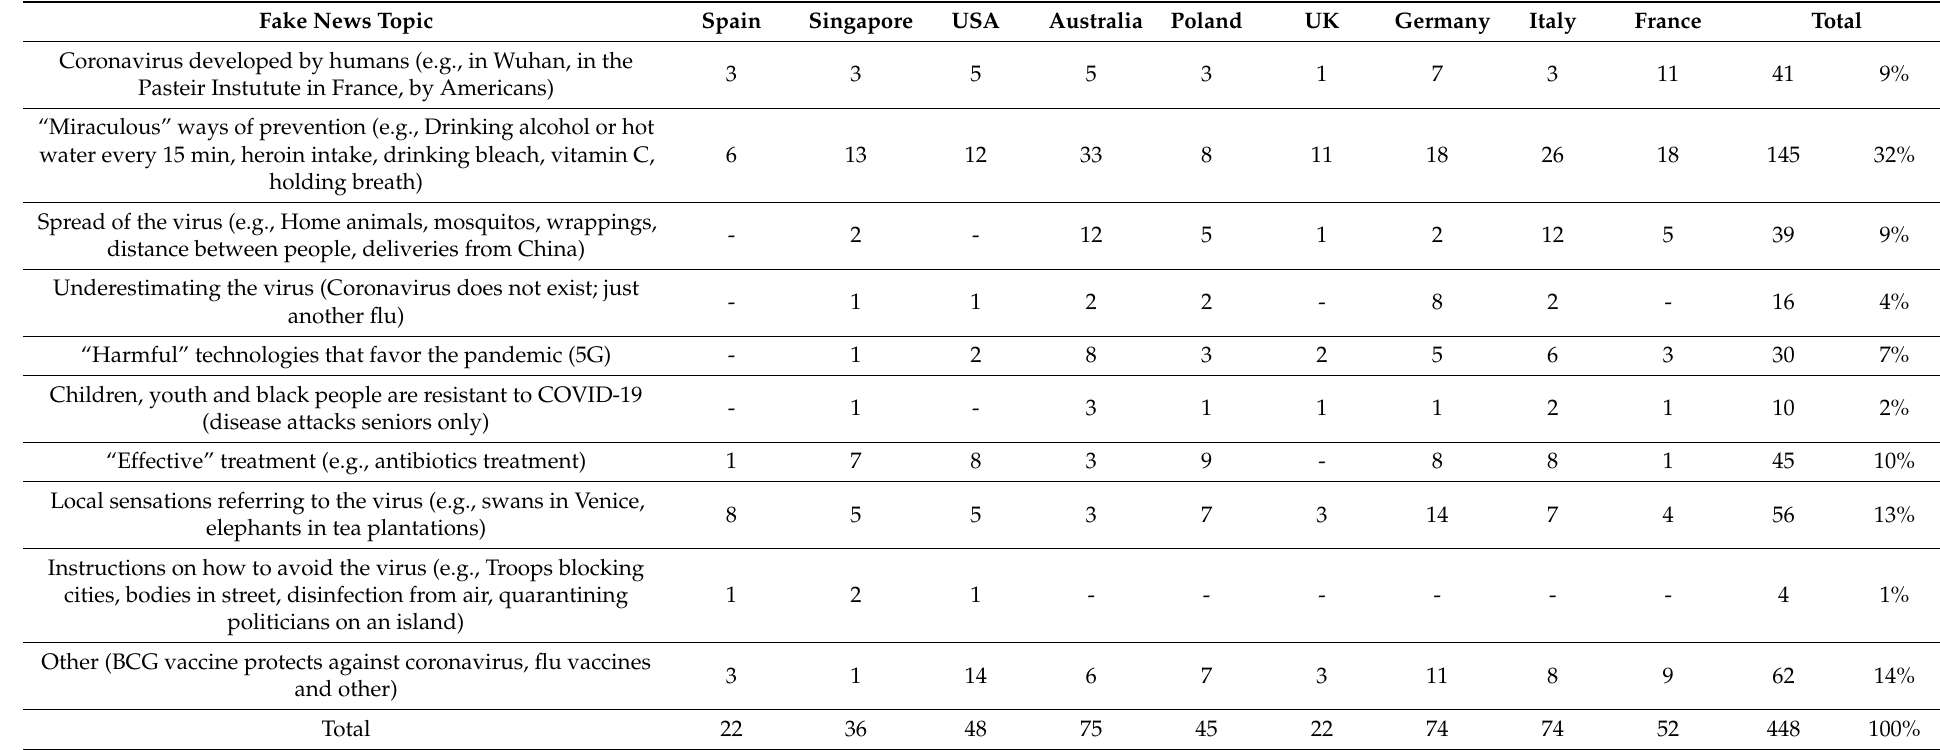
Table 3. Frequency of different types of fake news according to countries (N,